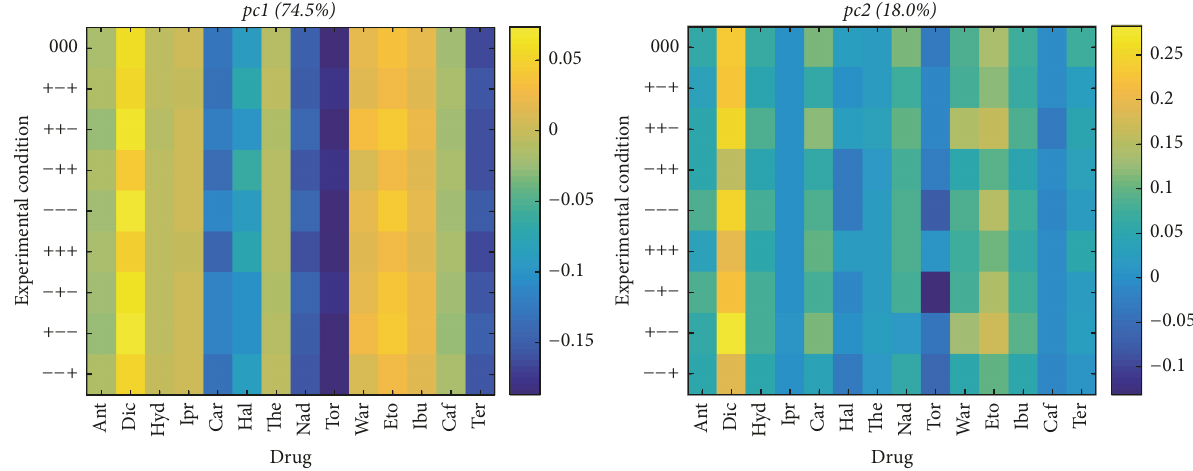
Figure 4: Composition of the loadings of the 8 × 126 matrix (8 columns described by 14 drugs in the 9 conditions).